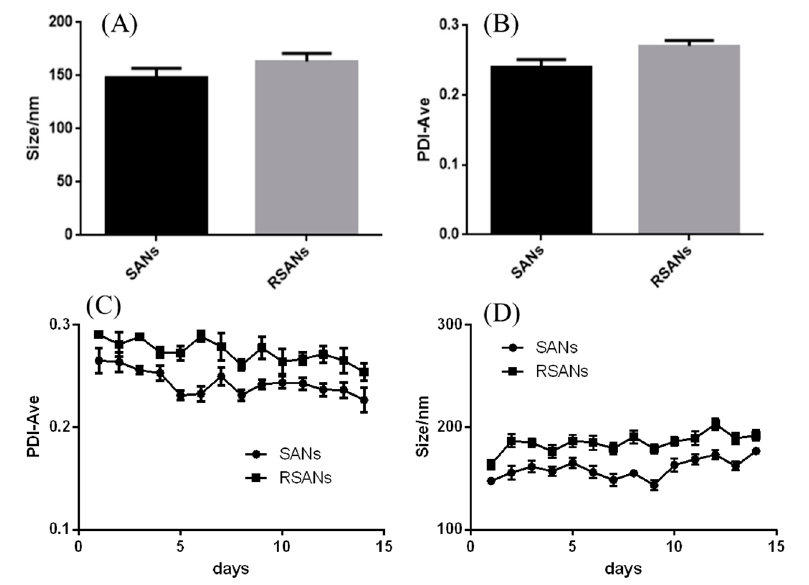
Figure 2. Particle size ( A ) and PDI ( B ) of SANs and RSANs. Changes of particle size ( D ) and PDI ( C ) within 15 days. Data are shown as ± SD ( n = 3) of mean ( n = 3).